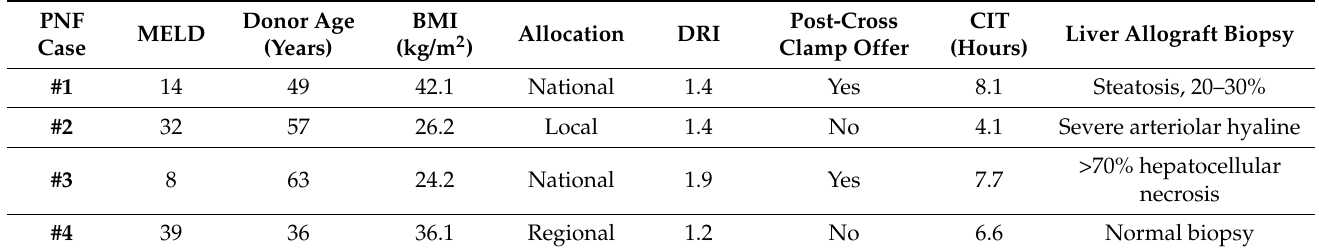
Table 5. Characteristics of grafts with EAD and